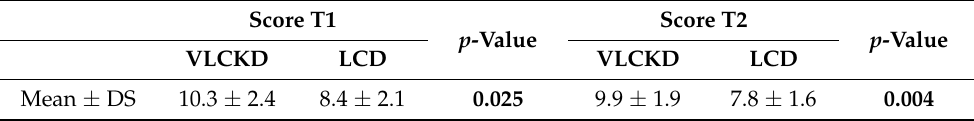
Table 7. Adherence diet score ( ± SD) at T1 and T2 in VLCKD and LCD